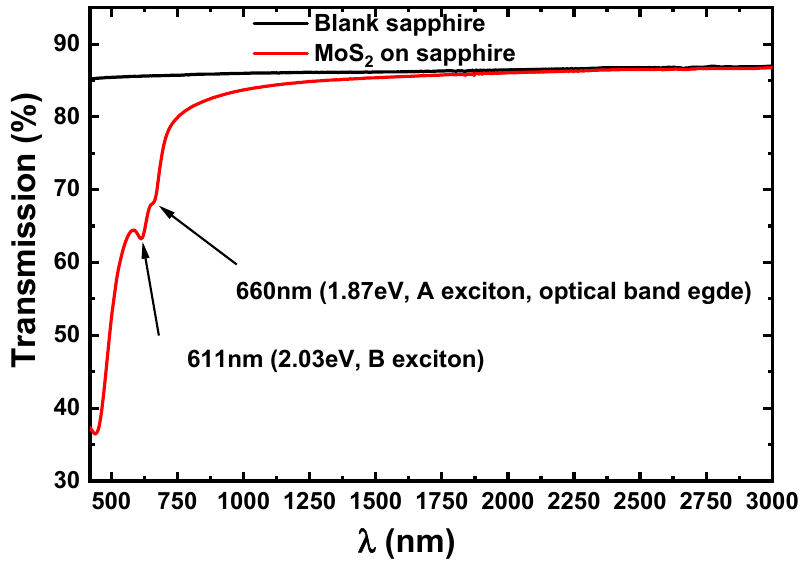
Figure 7. Transmission of 7 ML MoS 2 deposited on sapphire.